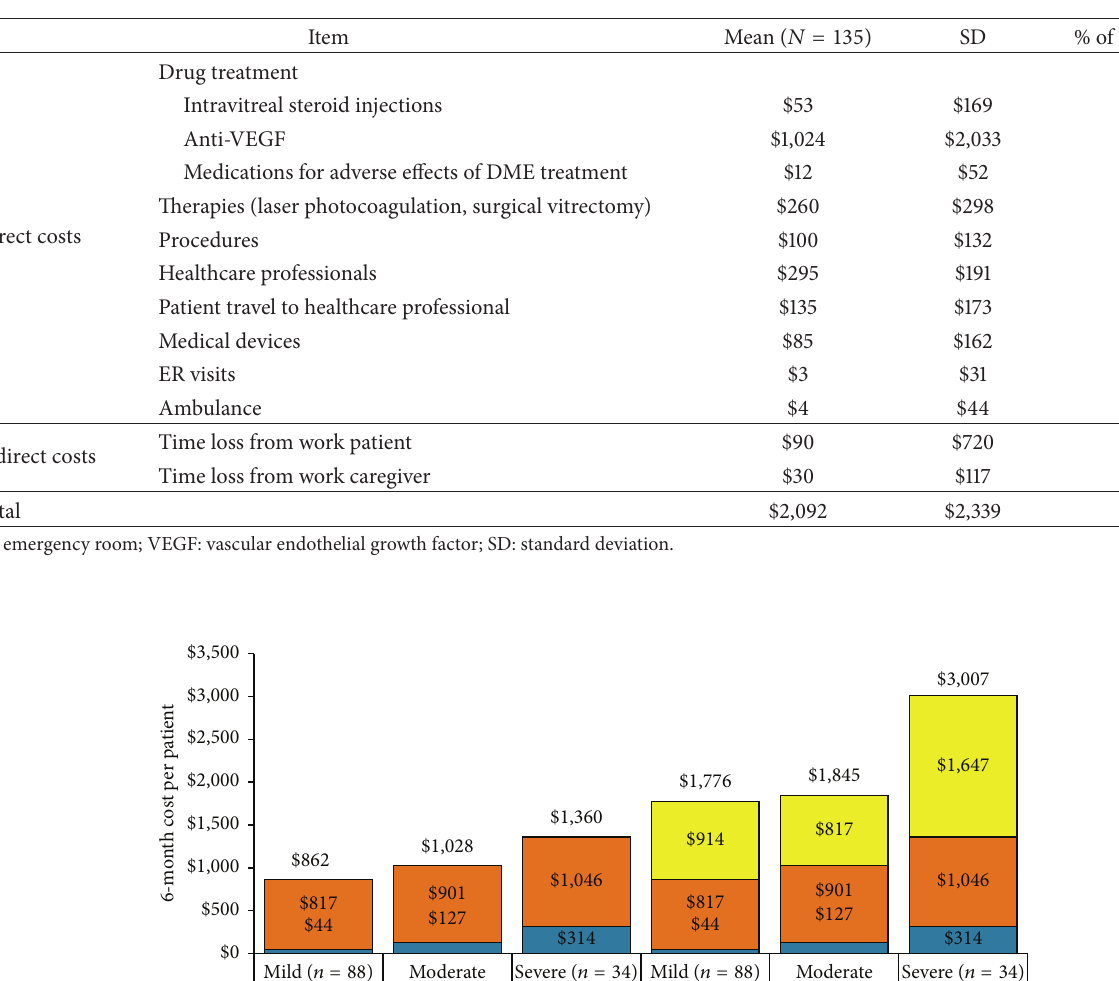
Table 3: Mean 6-month DME-related cost per patient.